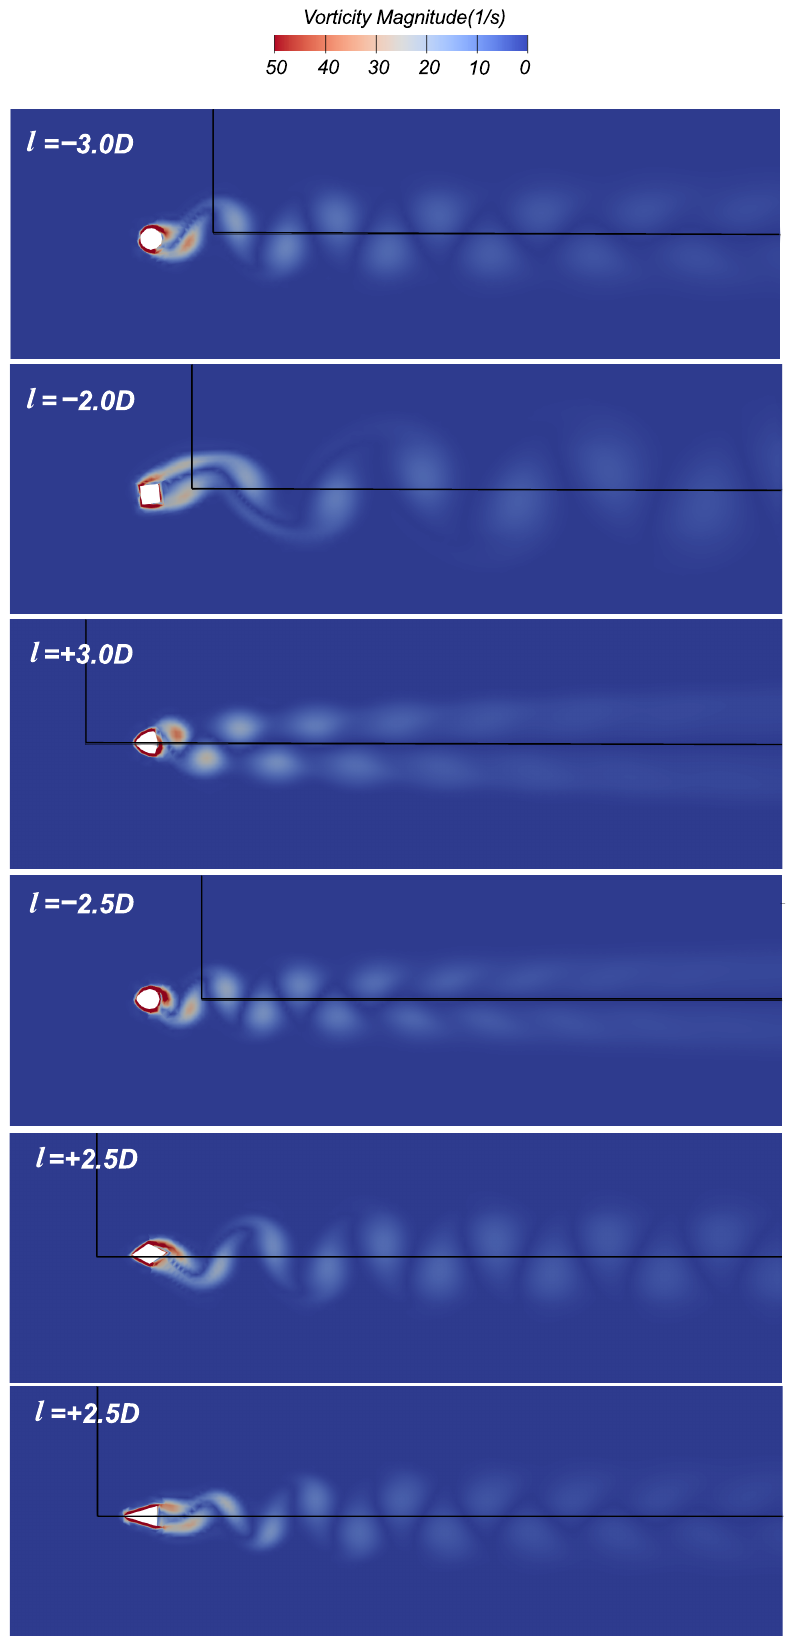
Figure 10. The steady state vorticity field for all cases with highest performance. The pivot is located at the origin of the black axes and the arm length is shown on top-left of each